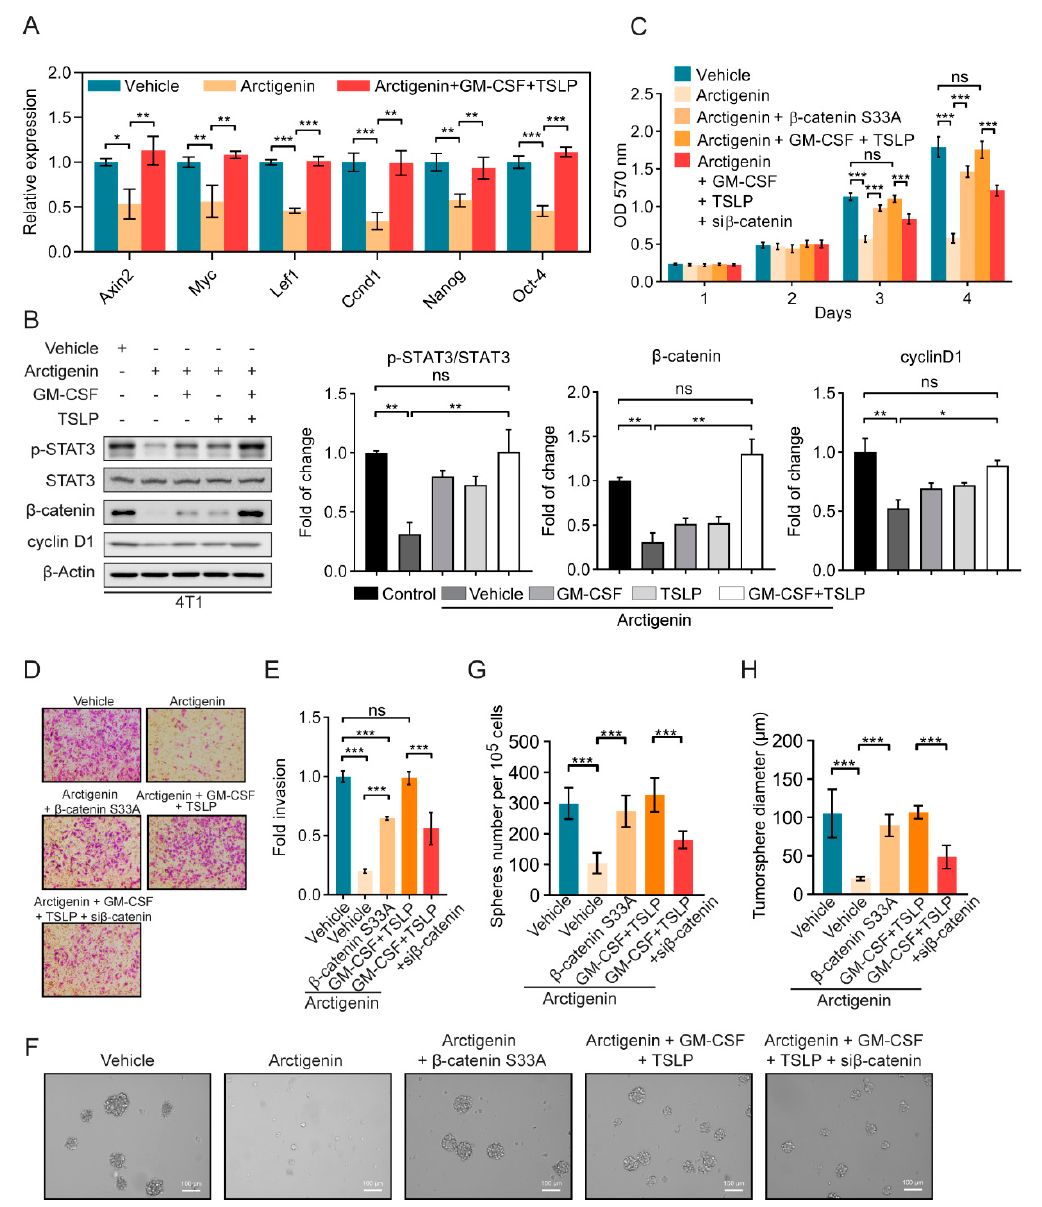
Figure 5. Arctigenin inhibits STAT3 / β -catenin signaling through decreasing GM-CSF and TSLP. ( A ) The expression of β -catenin downstream genes Axin2, Myc, Lef1, Ccnd1, Nanog and Oct4 were analyzed by qRT-PCR with the indicated treatments. ( B ) The expression levels of phosphorylated STAT3 (p-STAT3), STAT3, β -catenin and cyclin D1 were analyzed by Western blotting with the indicated treatments. ( C ) Cell proliferation analysis of 4T1 cells treated with arctigenin (20 µ M) in the presence or absence of GM-CSF (1 ng / mL), TSLP (100 ng / mL), or transfectd with β -catenin S33A construct or siRNA of β -catenin. ( D , E ) Representative images ( D ) and ( E ) statistics of the invaded 4T1 cells with the indicated treatments. ( F ) Representative images of the tumorsphere in 4T1 cells after indicated treatments. ( G , H ) Quantification of tumorspheres formation e ffi ciency ( G ) and tumorsphere diameter ( H ). For ( A – C , E , G , H ), ns, not significant, p > 0.05, * p < 0.05, ** p < 0.01, *** p < 0.001 (One-way ANOVA). Values represent mean ± SEM of three independent experiments.